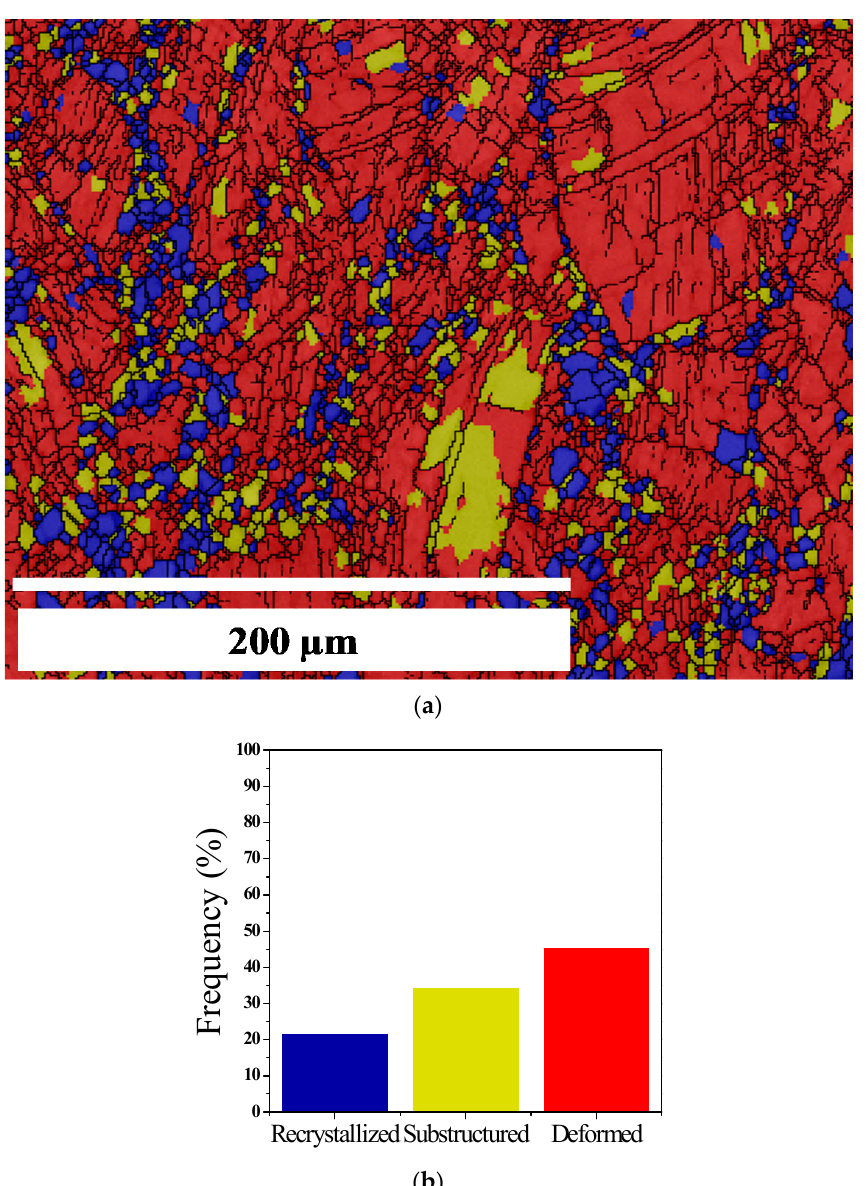
Figure 5. Recrystallized fraction for Sample B with delta-processing treatment and deformation: ( a ) Recrystallized grains (blue), substructured grains (yellow), deformed grains (red); ( b ) frequency (in %).